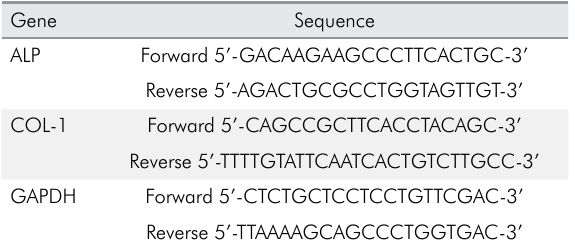
Table 2. Nucleotide sequence of primers used for each selected